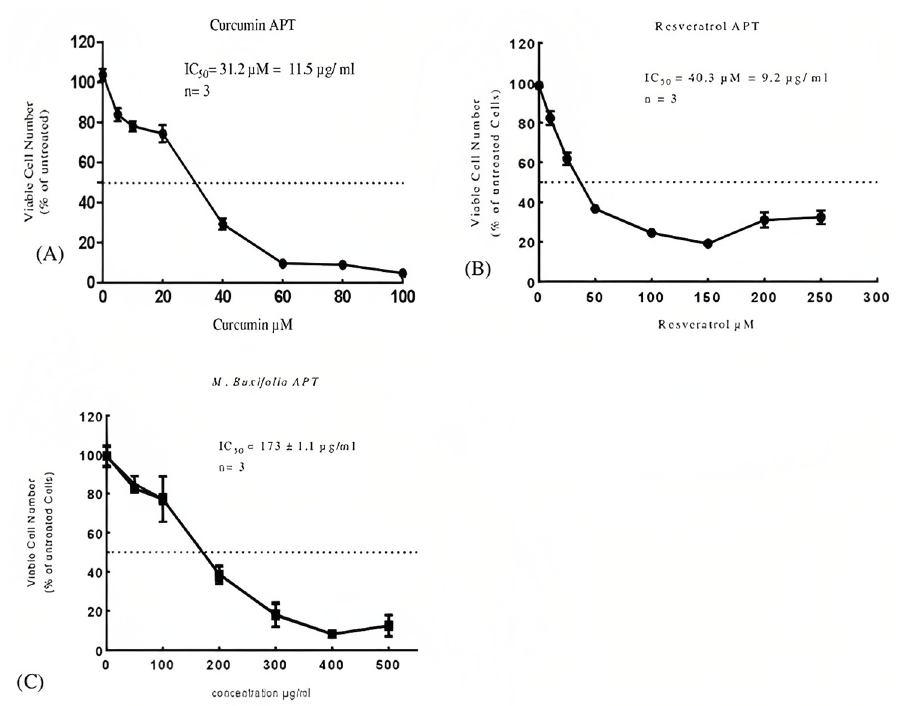
Figure 2. Analysis of percentage of MCF-7 cell death by acid phosphatase assay at different doses of ( A ) Curcumin, ( B ) Resveratrol, and ( C ) MMBL after 48h of incubation. Each value represents a mean ± SD ( n = 3). M. buxifolia = MMBL, MTT = (3-(4,5-dimethylthazolk-2-yl)-2,5-diphenyl tetra- zolium bromide) assay, APT = acid phosphatase